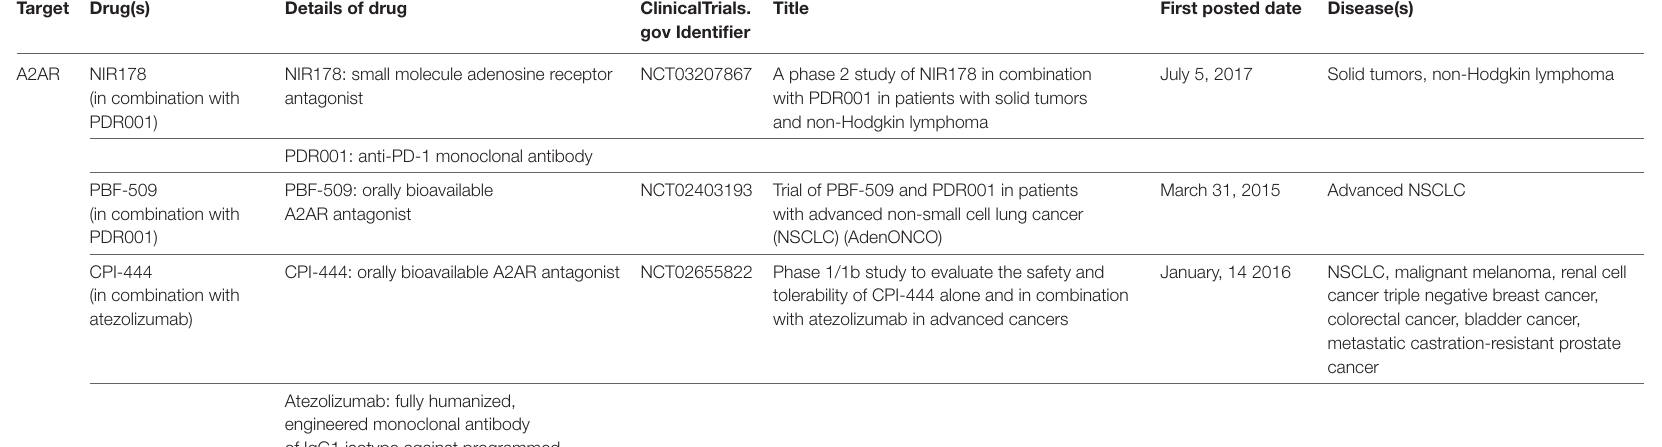
TAbLe 1 | List of drugs targeting A2A adenosine receptor (A2AR), cluster of differentiation 47 (CD47), and CD73 currently being investigated in clinical trials. Target Drug(s) Details of